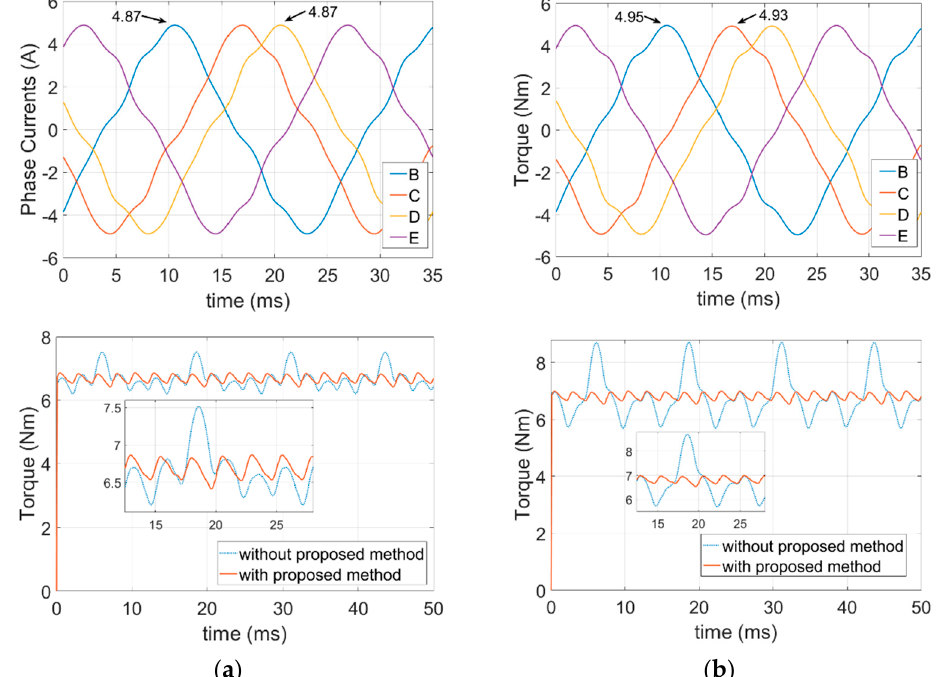
( b ) Figure 14. FEA torque waveforms for the fault-tolerant control currents of the NADPOC condition with and without the proposed method: ( a ) Only fundamental; ( b ) fundamental plus third har- monic.